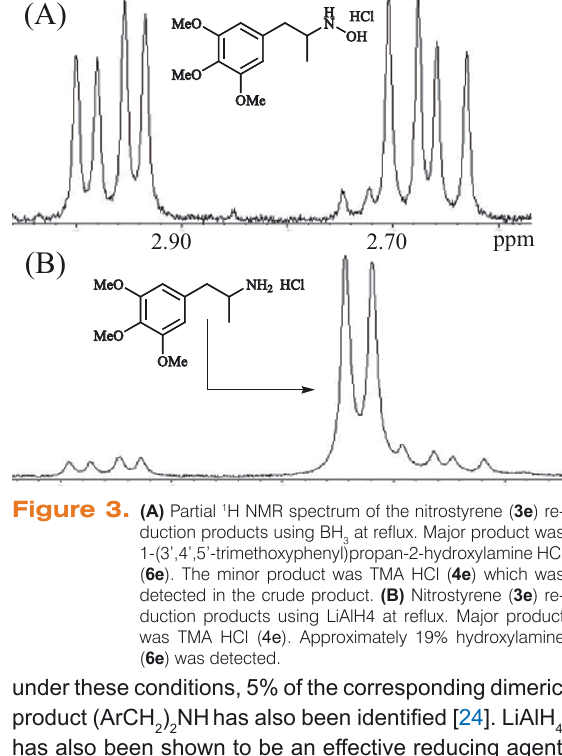
Figure 3. (A) Partial 1 H NMR spectrum of the nitrostyrene ( 3e ) re- duction products using BH at reflux. Major product was 3 1-(3’,4’,5’-trimethoxyphenyl)propan-2-hydroxylamine HCl ( 6e ). The minor product was TMA HCl ( 4e ) which was detected in the crude product. (B) Nitrostyrene ( 3e ) re- duction products using LiAlH4 at reflux. Major product was TMA HCl ( 4e ). Approximately 19% hydroxylamine ( 6e ) was